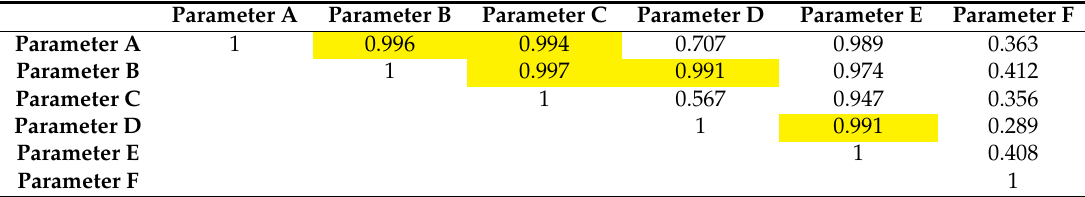
Table 3. Notional correlation